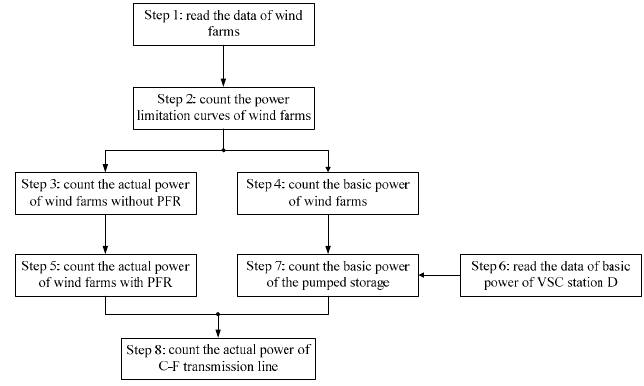
Figure 13. The Steps of the MTDC twenty-four-hour simulation program.